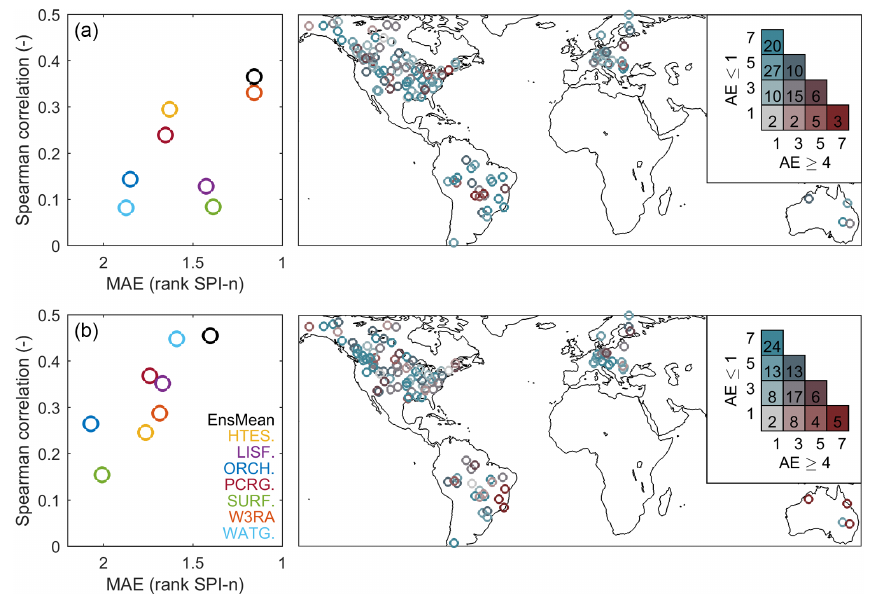
Figure 8. Comparison of model and observed summer (a) and winter (b) streamflow drought propagation timescales. The Spearman corre- lation and mean absolute error based on rank are compared, where better-performing models fall in the upper right corner. A map shows the number of models where the absolute error is ≤ 1 or ≥ 4 (right). The number of represented sites is indicated in the symbols of the